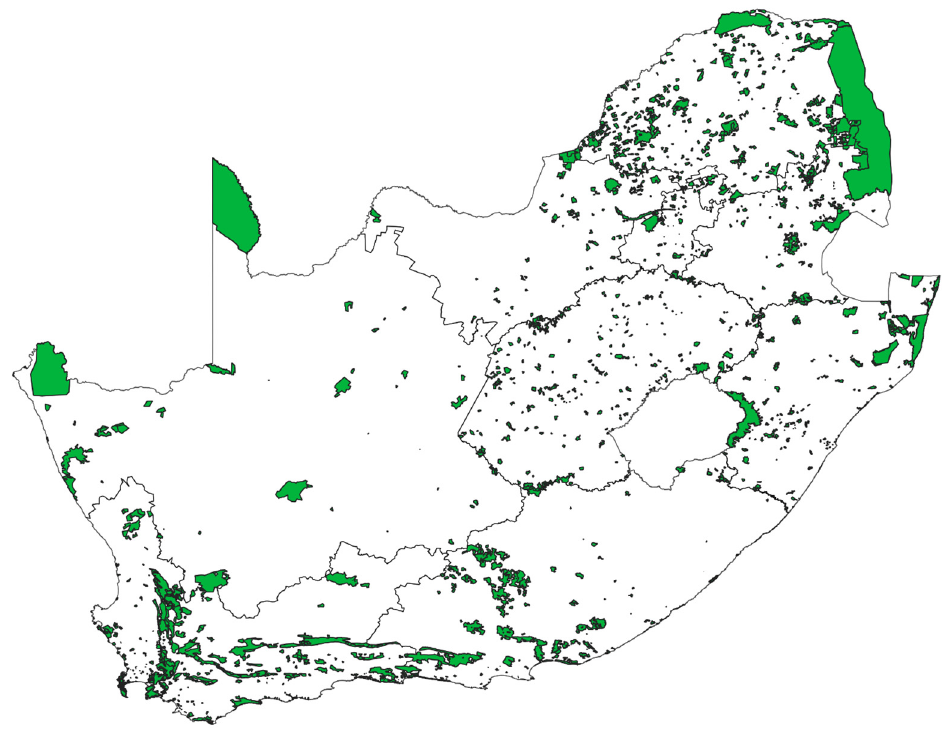
Figure 7. Map of all formally protected areas (green) within South Africa (created by G.K.N.).